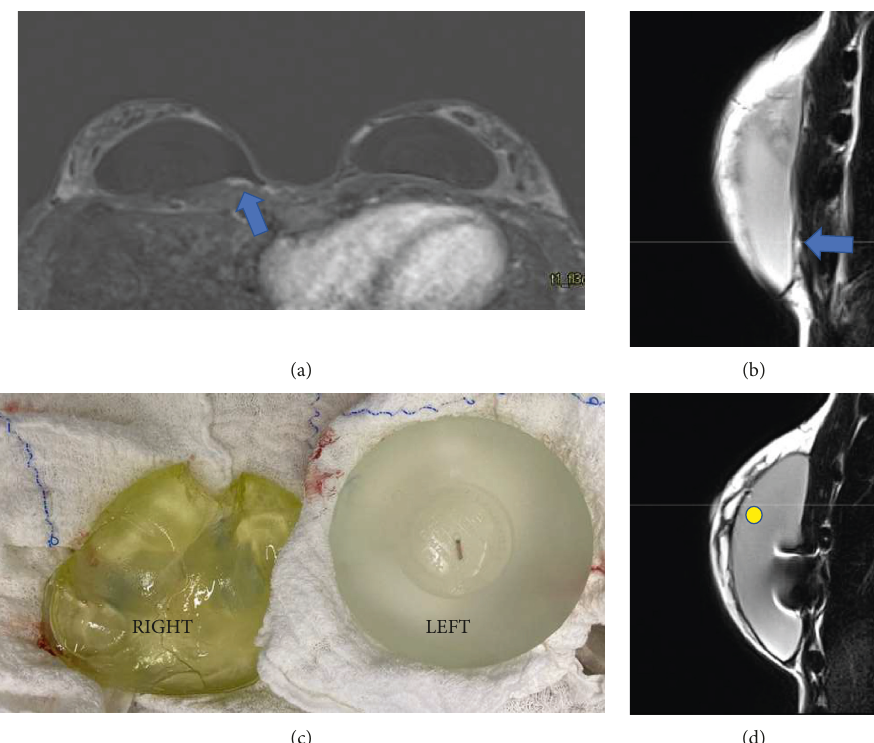
Figure 12: (a–d). A 37-year-old woman with nanotextured implant for 2 years, with BII complaints. Silicone granuloma in the right breast in postcontrast sequence (a) and proton-density (b) market with the blue arrow. The explant product confirming the MR findings, where the right implant shows surface degradation and color change (c). Figure D shows the radiofrequency identification artifacts and the water- droplet signal (yellow